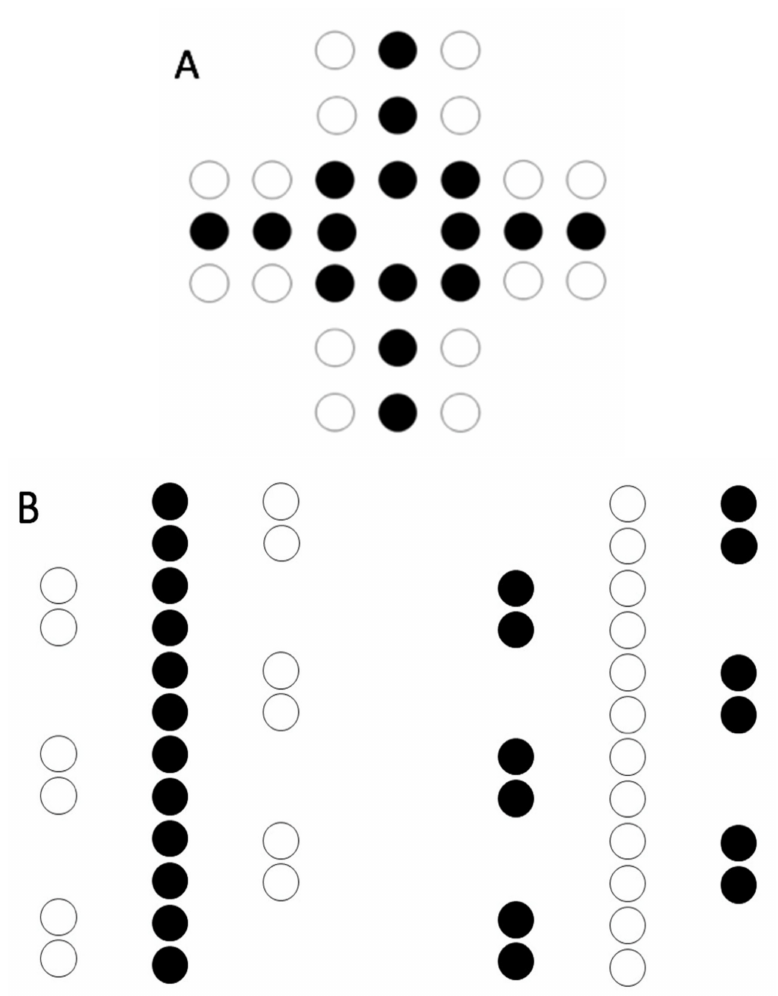
Figure 1. The original Solitaire illusion array ( A ) and the linear version of the Solitaire illusion used in Experiments 2 and 3. Black dots represent inedible items and white dots represent food items ( B